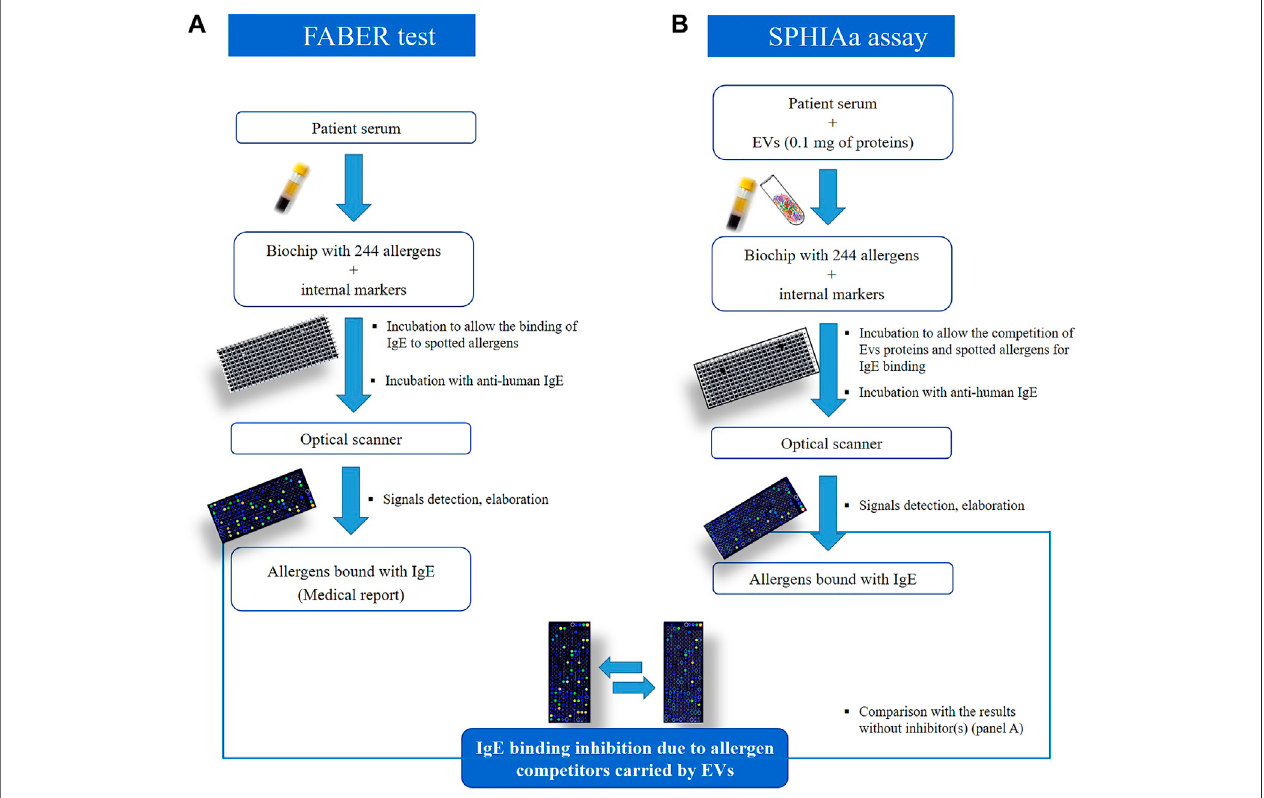
FIGURE3| Schematicrepresentation tocomparetheFABERteston (A) ,whichisusedforallergydiagnosisandresearchpurposes, totheprocedureusedforthe Single Point Highest Inhibition Achievable assay (SPHIAa) assay (B) .